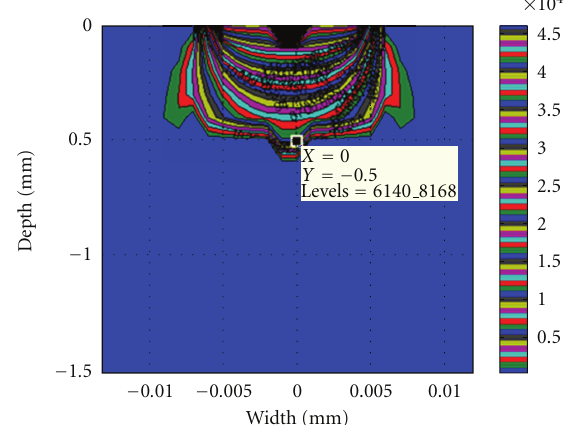
Figure 7: The hole depth versus the hole